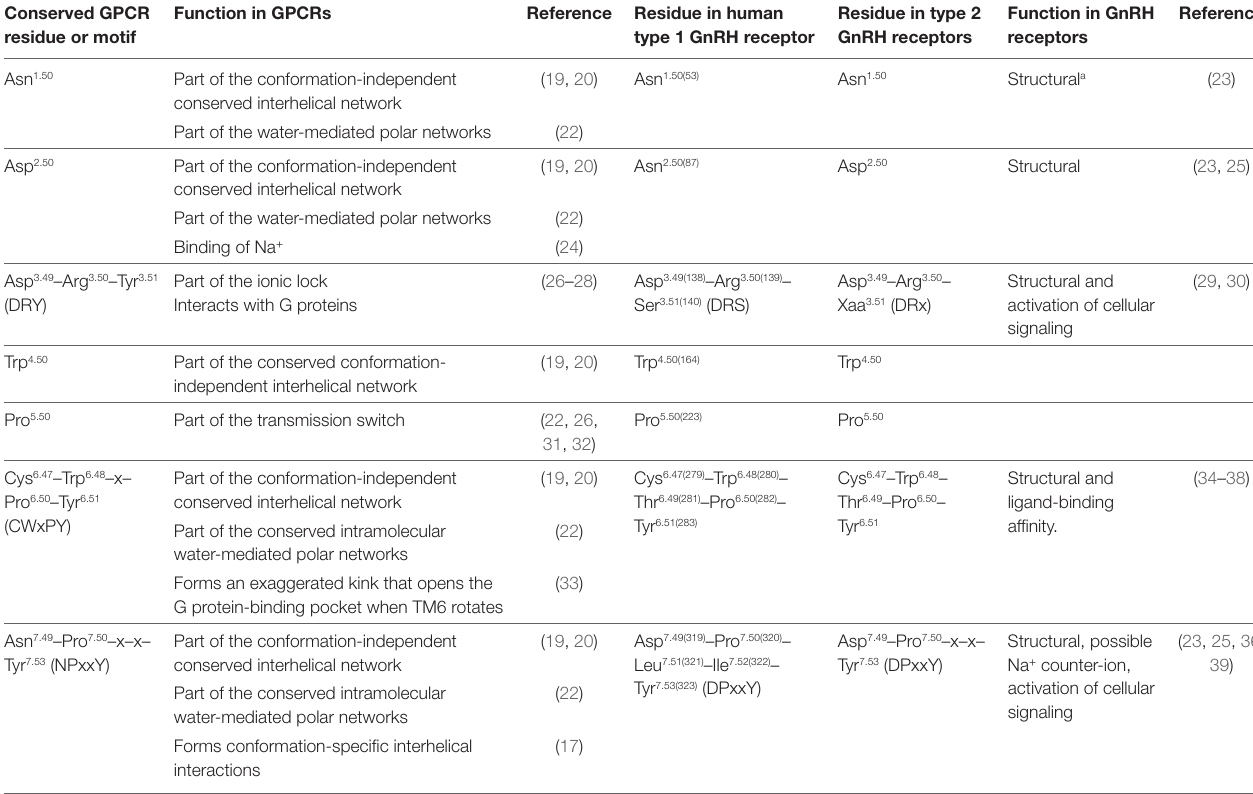
TABle 1 | Highly conserved amino acid residues and motifs in class A GPCRs and equivalent residues in type 1 and type 2 GnRH receptors. Conserved GPCR residue or